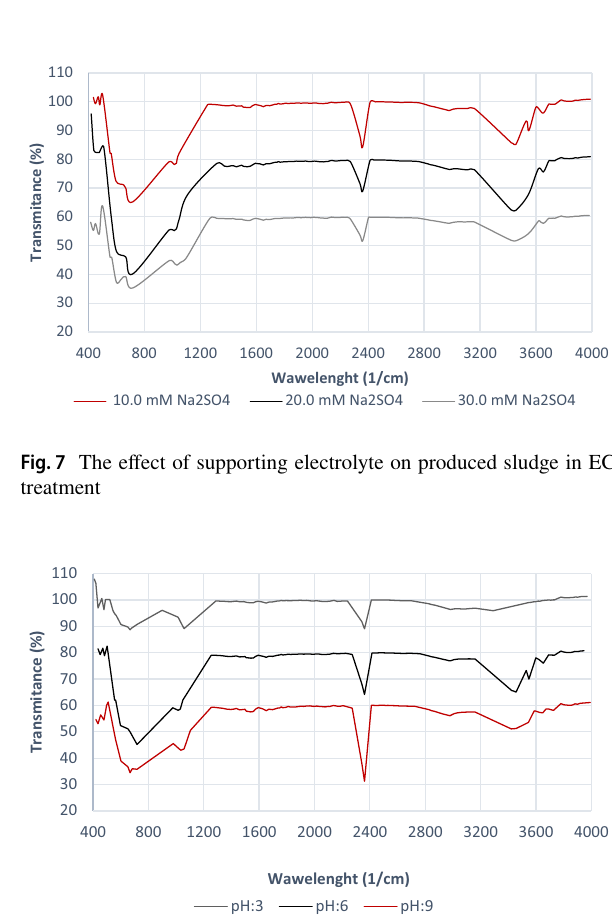
Fig. 6 The effect of current density on produced sludge in EC treat- ment